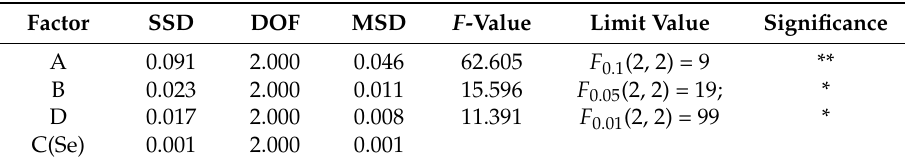
Table 16. The analysis of